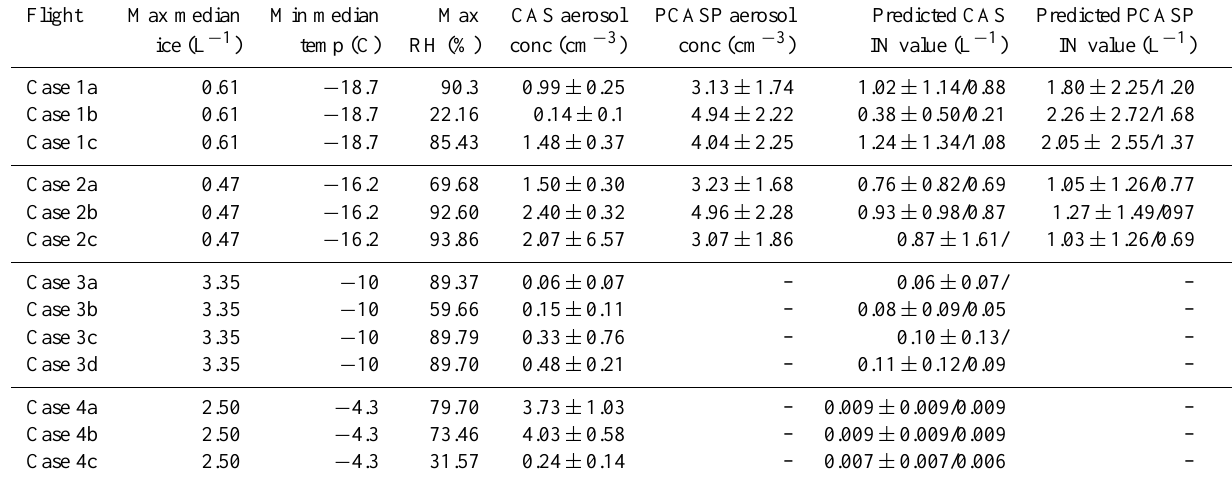
Table 2. Measurements of aerosol concentrations >0.5µm from the CAS and PCASP probes, together with predicted primary IN number using the DeMott et al. (2010) (D10) scheme (with either CAS or PCASP aerosol concentration data as input). Observed minimum median cloud temperatures were input to D10, and IN predictions were compared with observed maximum median ice